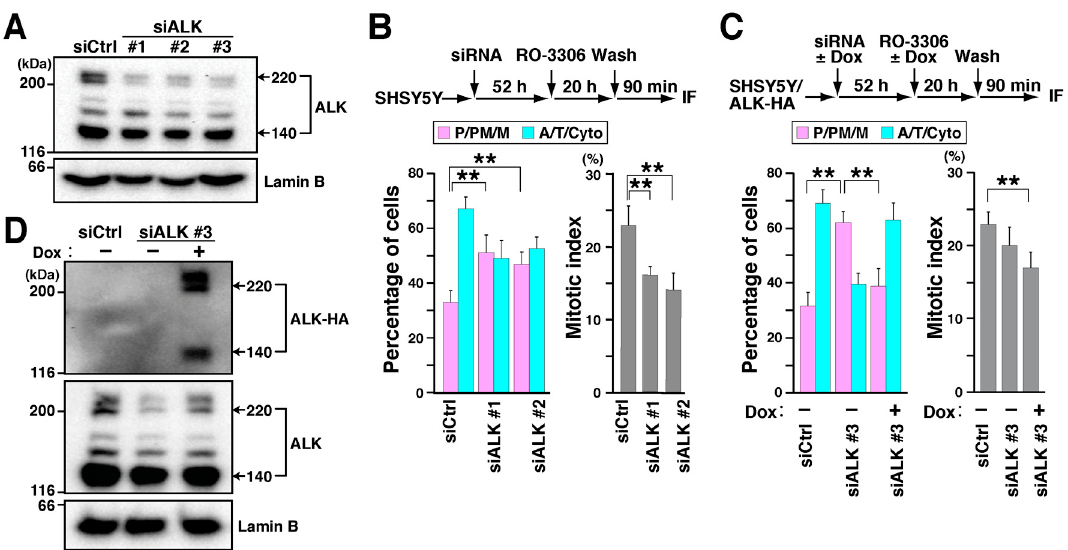
Figure 3. ALK is responsible for ALK-inhibitor-induced M phase delay. ( A ) SH-SY5Y cells were transfected with ALK-targeting siRNAs (siALK #1, #2, and #3) or nontargeting siCtrl. At 72 h after transfection, whole cell lysates were prepared and analyzed by western blotting. ( B ) At 52 h after siRNA transfection, SH-SY5Y cells were synchronized with 4 µ M RO-3306 and then cultured in fresh media for 90 min. Based on microtubule and chromosome morphology, M phase cells were classified into two groups: before (P / PM / M) or after (A / T / Cyto) anaphase onset. Percentages of cells ( n > 243 in each experiment) and mitotic indices ( n > 503 in each experiment) are plotted as the mean ± SD calculated from three independent experiments. ( C , D ) SH-SY5Y / ALK-HA cells were transfected with siRNA targeting the 3’-UTR region of ALK (siALK #3) or nontargeting siCtrl and were simultaneously treated with 5 µ g / mL Dox. ( C ) Fifty-two hours after transfection, the cells were synchronized with RO-3306 and M phase progression was analyzed as described in ( B ). Percentages of cells ( n > 193 in each experiment) and mitotic indices (n > 413 in each experiment) are plotted as the mean ± SD of three independent experiments. The Tukey–Kramer multiple comparison test was used to calculate p